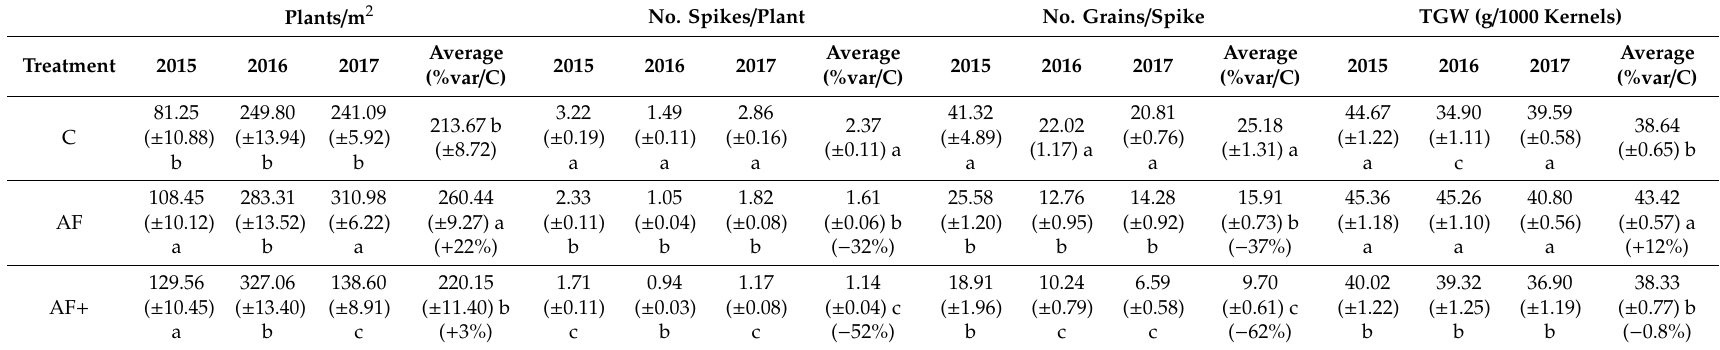
Table 3. Yield components of durum wheat grown in the C, AF, and AF + treatments (means of all genotypes in 2015, 2016, and 2017). Number of plants per square meter, number of spikes per plant (where one plant means one seed sown), number of grains per spike, and thousand-grain weight (TGW). Plants / m 2 No. Spikes / Plant No. Grains / Spike TGW (g / 1000